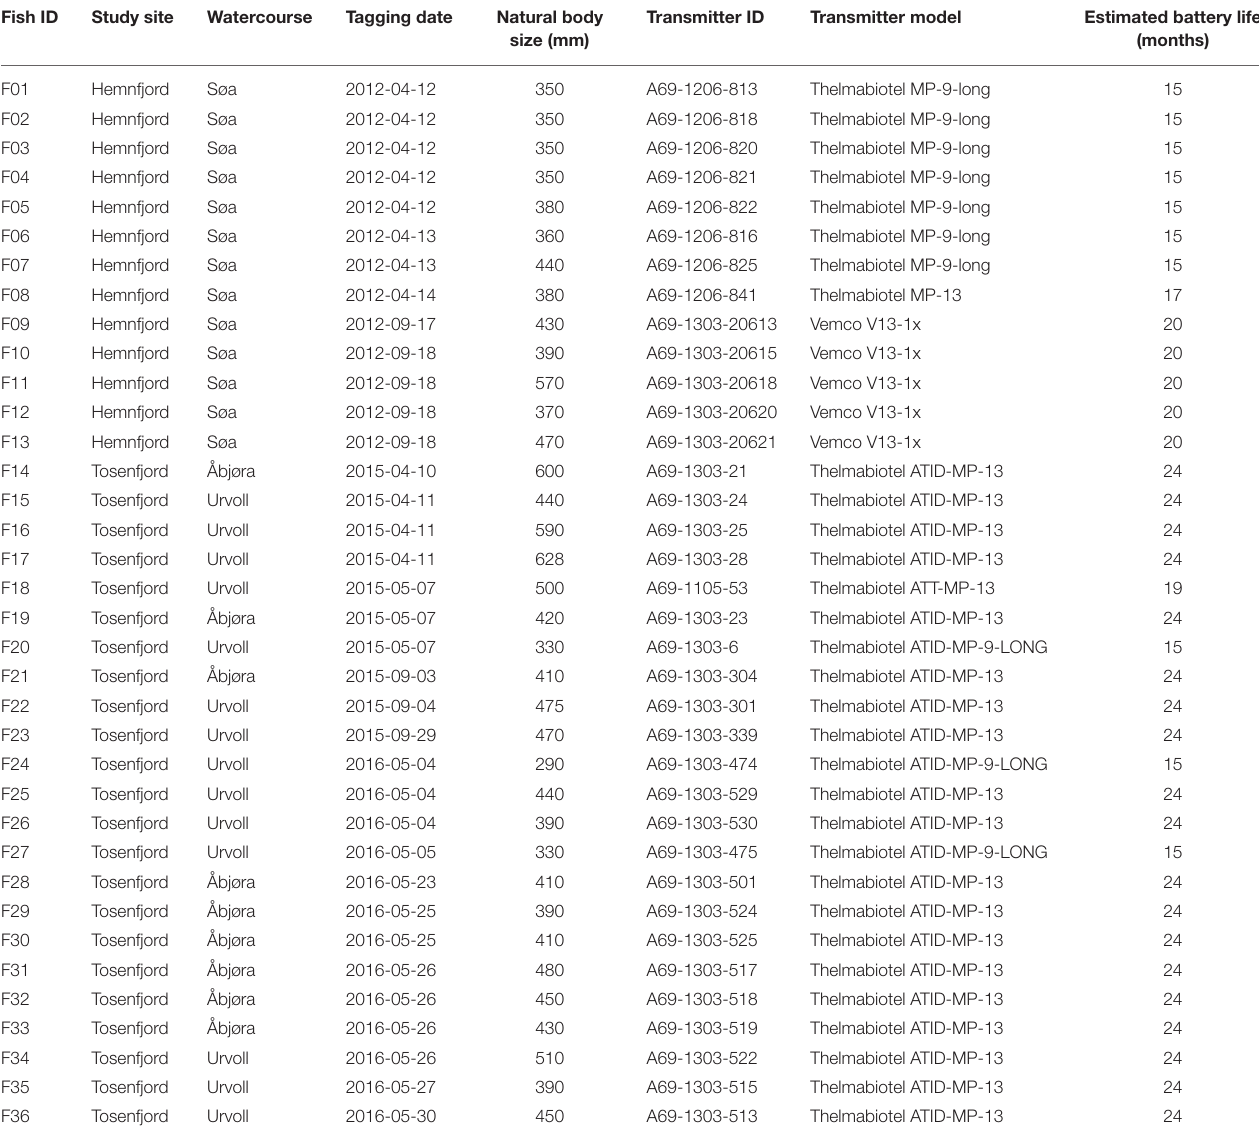
TABLE 1 | Summary of capture timing and location, body size, and tag information of tracked